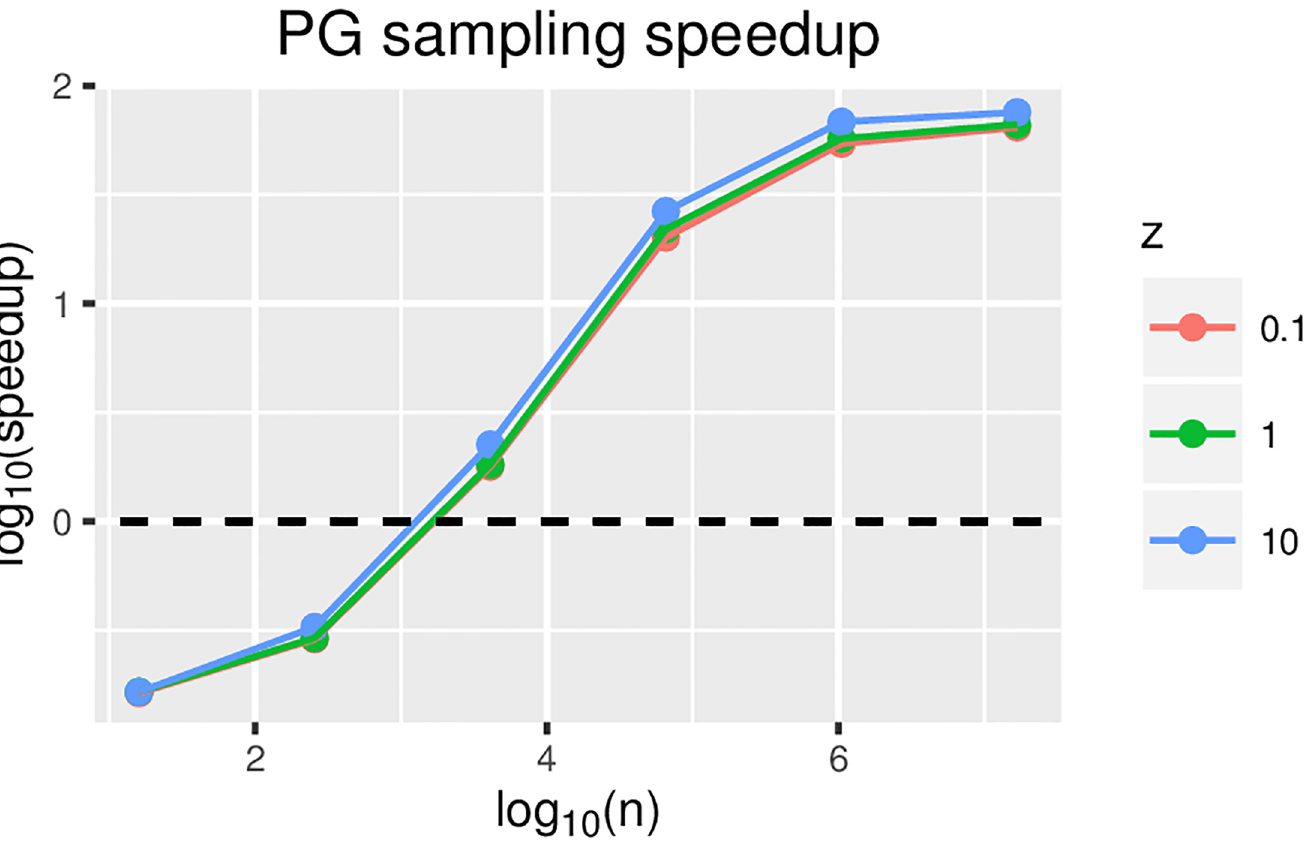
Fig 8. Polya-Gamma sampling speedup for GTX1070 relative to the CPU-only version (on an Intel i5-6600K@ 3.50 GHz) for increasing problem size and different values of z .